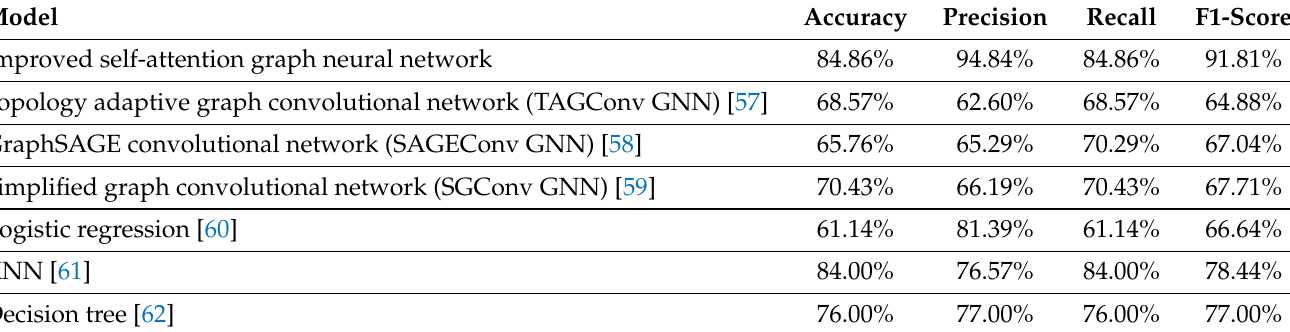
Table 4. The two-category classification results on the test set.